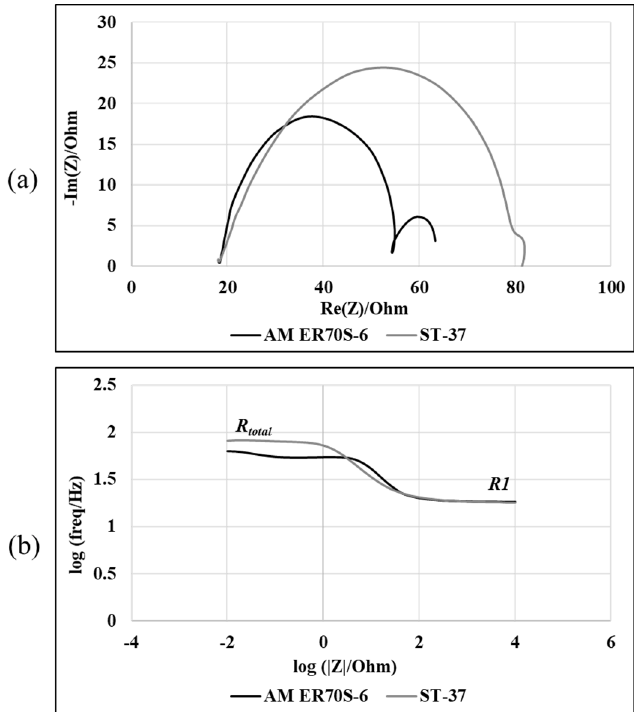
Figure 5. Electrochemical impedance spectroscopy of additively manufactured ER70S-6 alloy and reference ST-37 alloys in 3.5% NaCl solution: ( a ) Nyquist diagram; ( b ) Bode magnitude diagram.